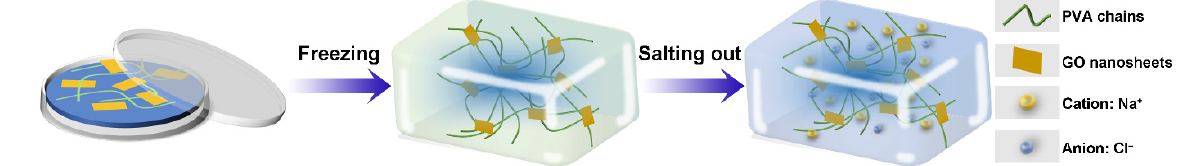
Figure 1. Schematic illustration of the formation process of PVA/GO ionic conductive hydrogel under the synergistic action of freezing and salting out.